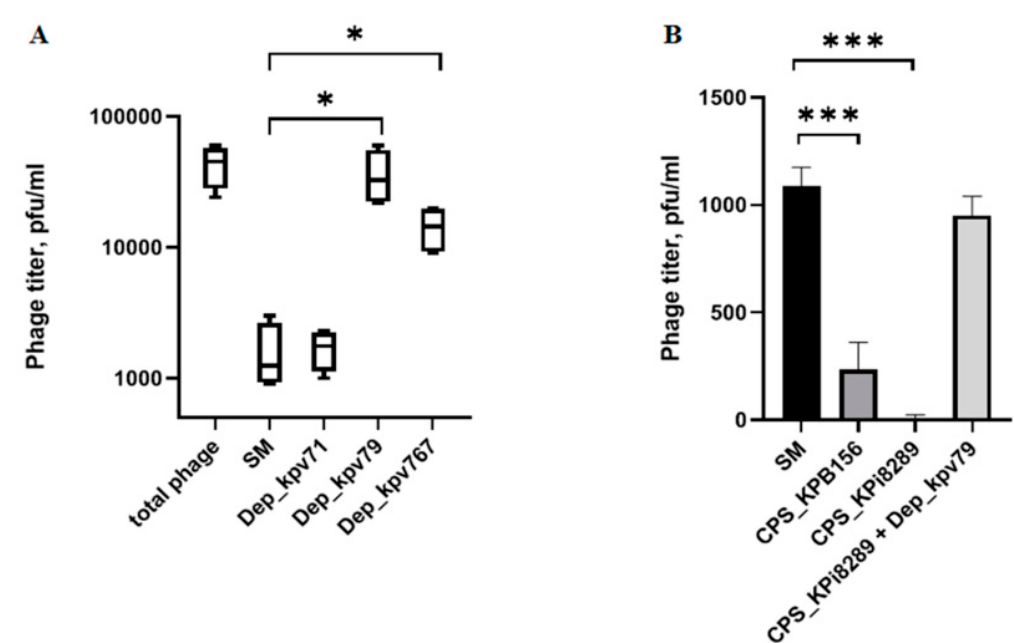
Figure 3. Phage KpV79 adsorption inhibition assay and phage inactivation by CPS. ( A ) From left to right, a titer of the total phage sample and titers of the free phage particles after the 5 min incubation with KpV79-sensitive K. pneumoniae KPi8289 cells in SM buffer and in the presence of Dep_kpv71, Dep_kpv79, and Dep_kpv767. ( B ) Purified CPS’s from K. pneumoniae KPB156 and KPi8289, as well as CPS KPi8289 pre-treated with PS-depolymerase Dep_kpv79, were added to identical phage samples and, after 10 min of incubation, aliquots were taken and titrated. Pure SM buffer was used as a negative control. Average titers from three independent experiments are shown and compared using Student’s t -test analysis. * p < 0.05, *** p < 0.001